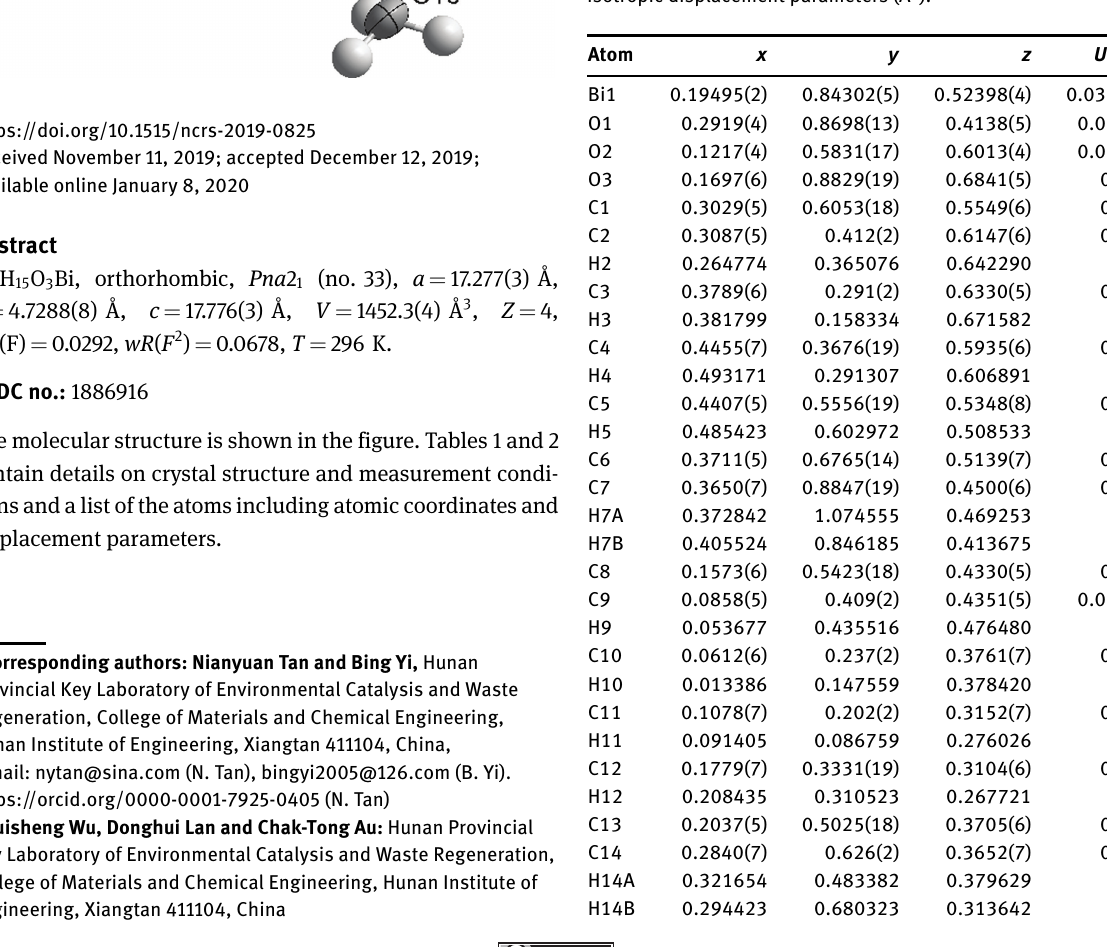
Table 2: Fractional atomic coordinates and isotropic or equivalent isotropic displacement parameters (Å 2